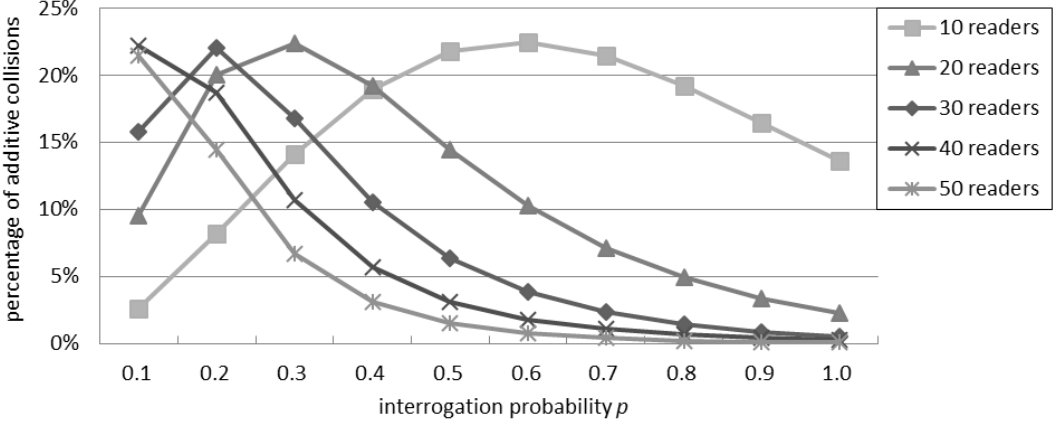
Figure 4. Percentage of additive collisions for the additive interference model in the probabilistic interrogation